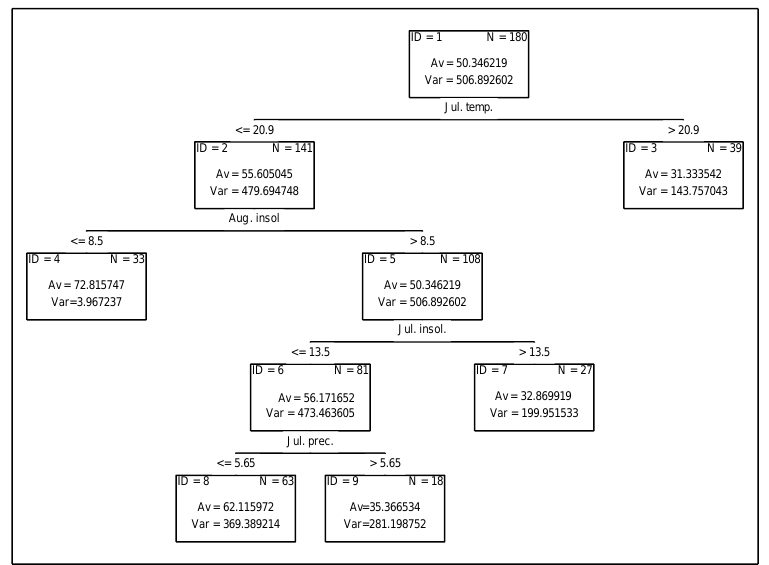
Figure 5. Diagram of regression tree reflecting nitrogen acquisition from the atmosphere by soybean plants treated with Asahi.